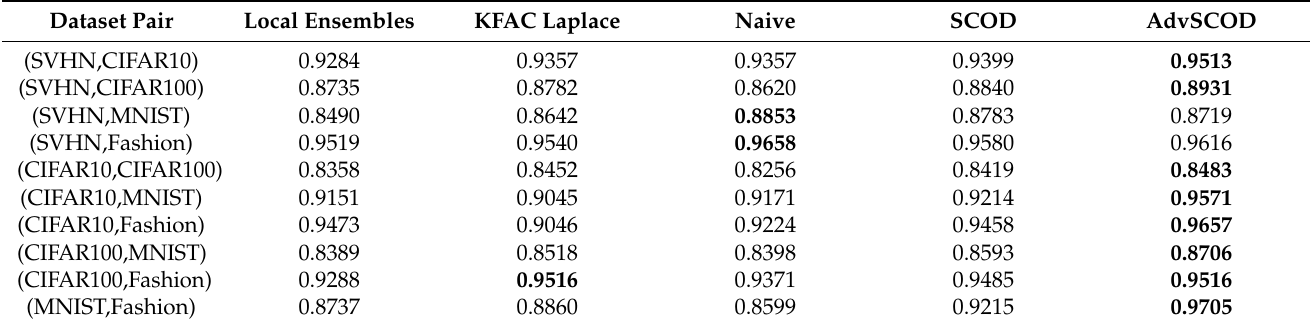
Table 2. Comparison of the OOD detection performance measured by AUROC avg . Bold numbers are superior results.